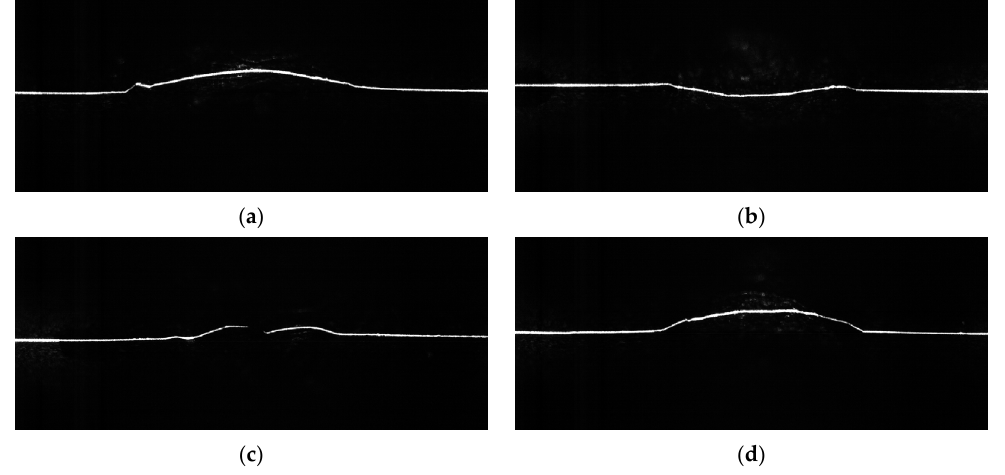
Figure 6. The images show structured-light images of different weld defect type classifications with sizes of 1080 × 520 collected by the experimental equipment: ( a ) burr structured-light image; ( b ) concav- ity structured-light image; ( c ) porosity structured-light image; ( d ) defect-free structured-light image.